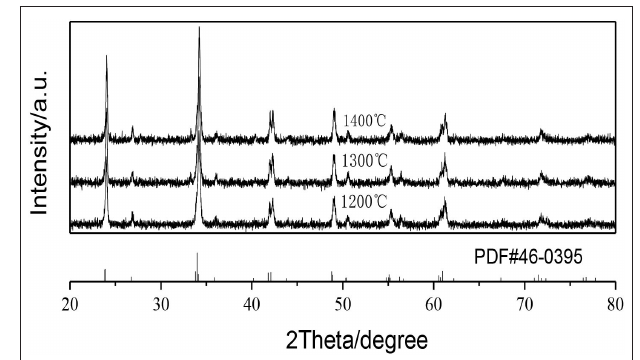
FIGURE 1 | XRD patterns of the GAP phosphors prepared by calcining the precipitate at different temperatures.